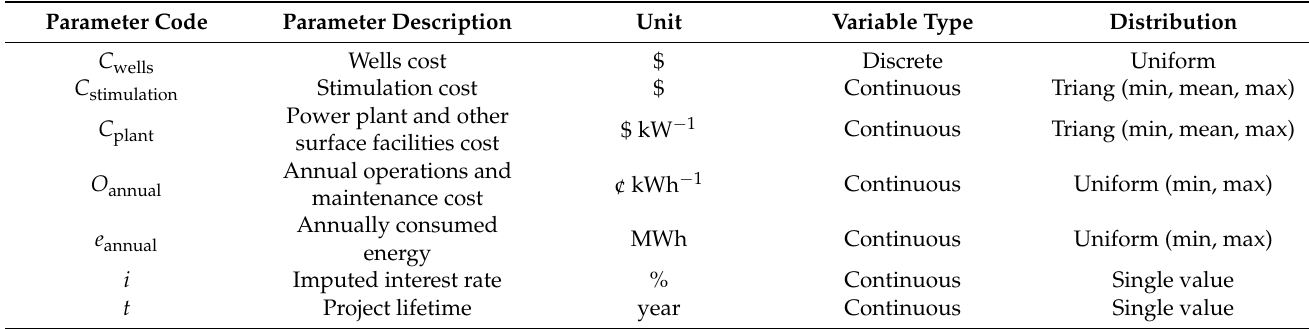
Table 3. Levelized cost of energy and